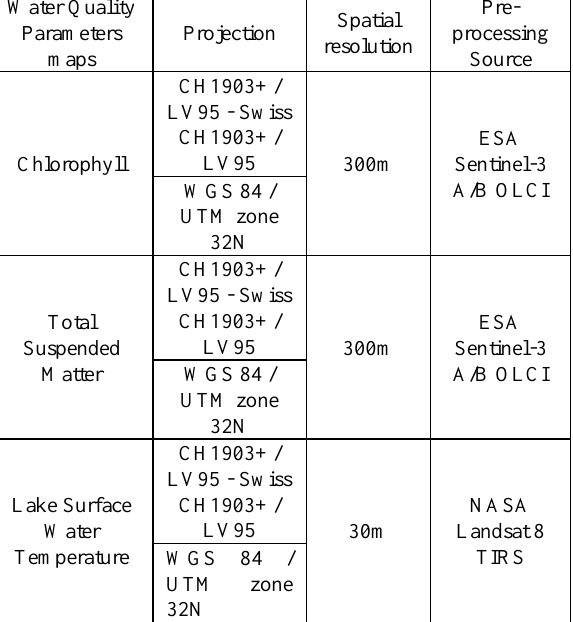
Table 2. Processed water quality maps currently ingested into the platform